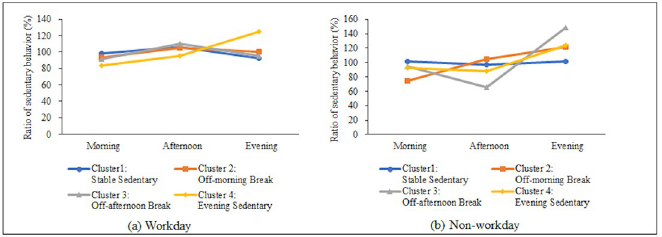
Fig 2. Diurnal patterns of sedentary behavior in four clusters. Variation level of sedentary time during each time period was based on the time period/whole day ratio. (a) Variation level of the workday was calculated as the percentage of sedentary time during each time period on workdays, divided by the percentage of the total sedentary time on the whole workday. (b) Variation level of the non-workday was calculated as the percentage of sedentary time during each time period on non-workdays divided by the percentage of total sedentary time on the whole non- workday.